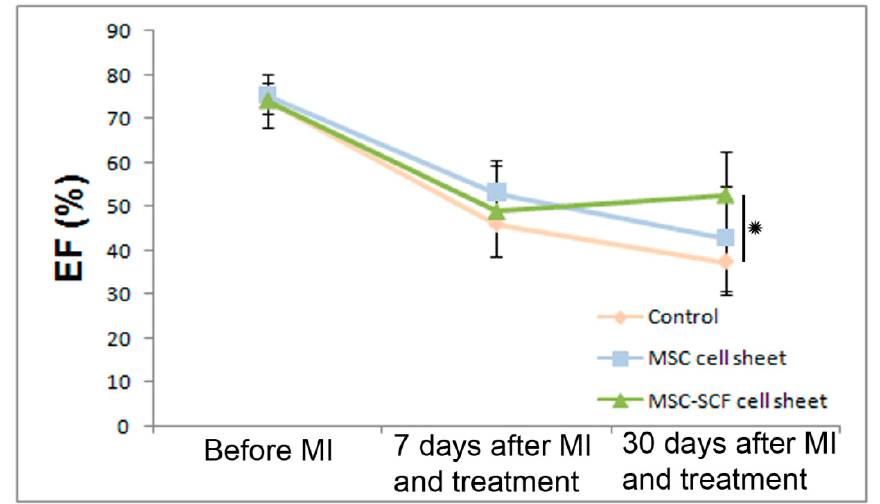
Figure 6. Vascularization of ischemic myocardium at day 5 and 14 after MSC sheet transplantation. ( a , b ) Representative images of CD31 positive vascular structures (green) in ischemic myocardium covered by CS comprised of pre-labelled MSC (red). Day 14 after MI induction. Nuclei are stained with DAPI (blue). White arrows ( b ) indicate vascular structures present in the cell sheet. ( c ) Capillaries and lumen vessel count in FOVs covering the adjacent to CS region. The black asterisk ( ⁕ ) indicates statistical significance vs. control group; ( d ) Capillaries vessel count. The black asterisk ( ⁕ ) indicates statistical significance vs. control group; ( e ) Lumen vessel count. Data are presented as mean ± SD (Mann–Whitney U-test). Scale bar-100